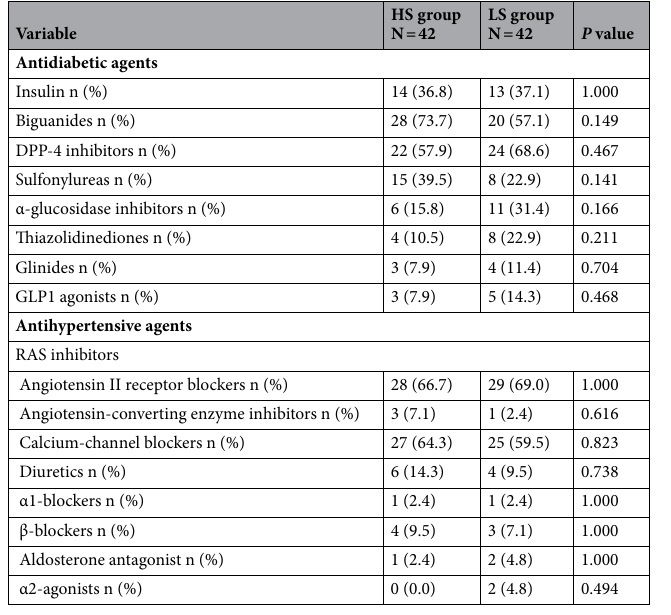
Table 2. Baseline medications of the participants. Analyses were performed using unpaired t -tests for continuous data and Fisher’s exact tests for categorical data. HS group high sodium intake group, LS group